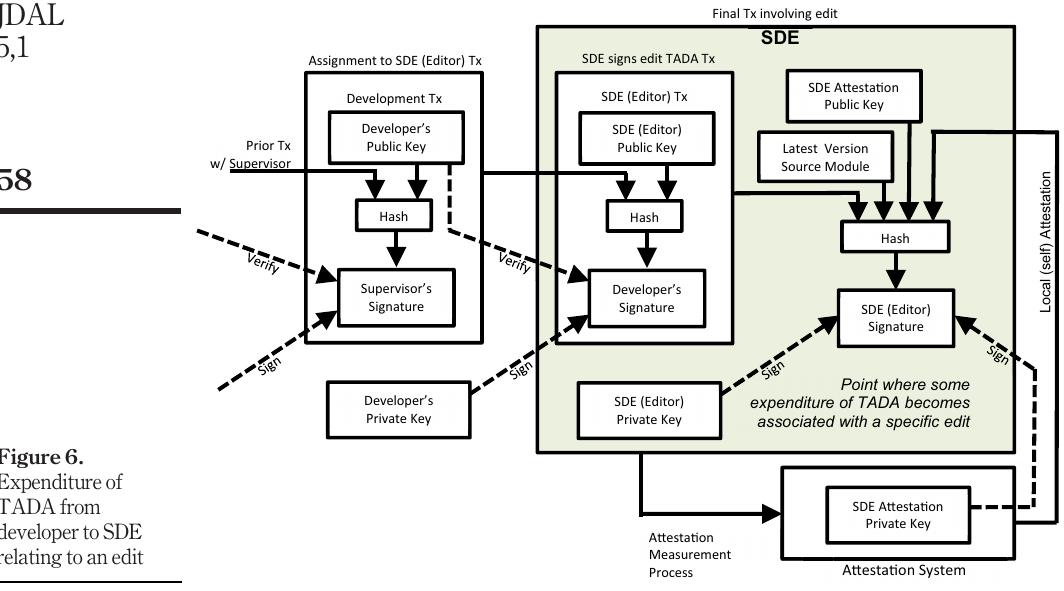
Figure 6. Expenditure of TADA from developerto